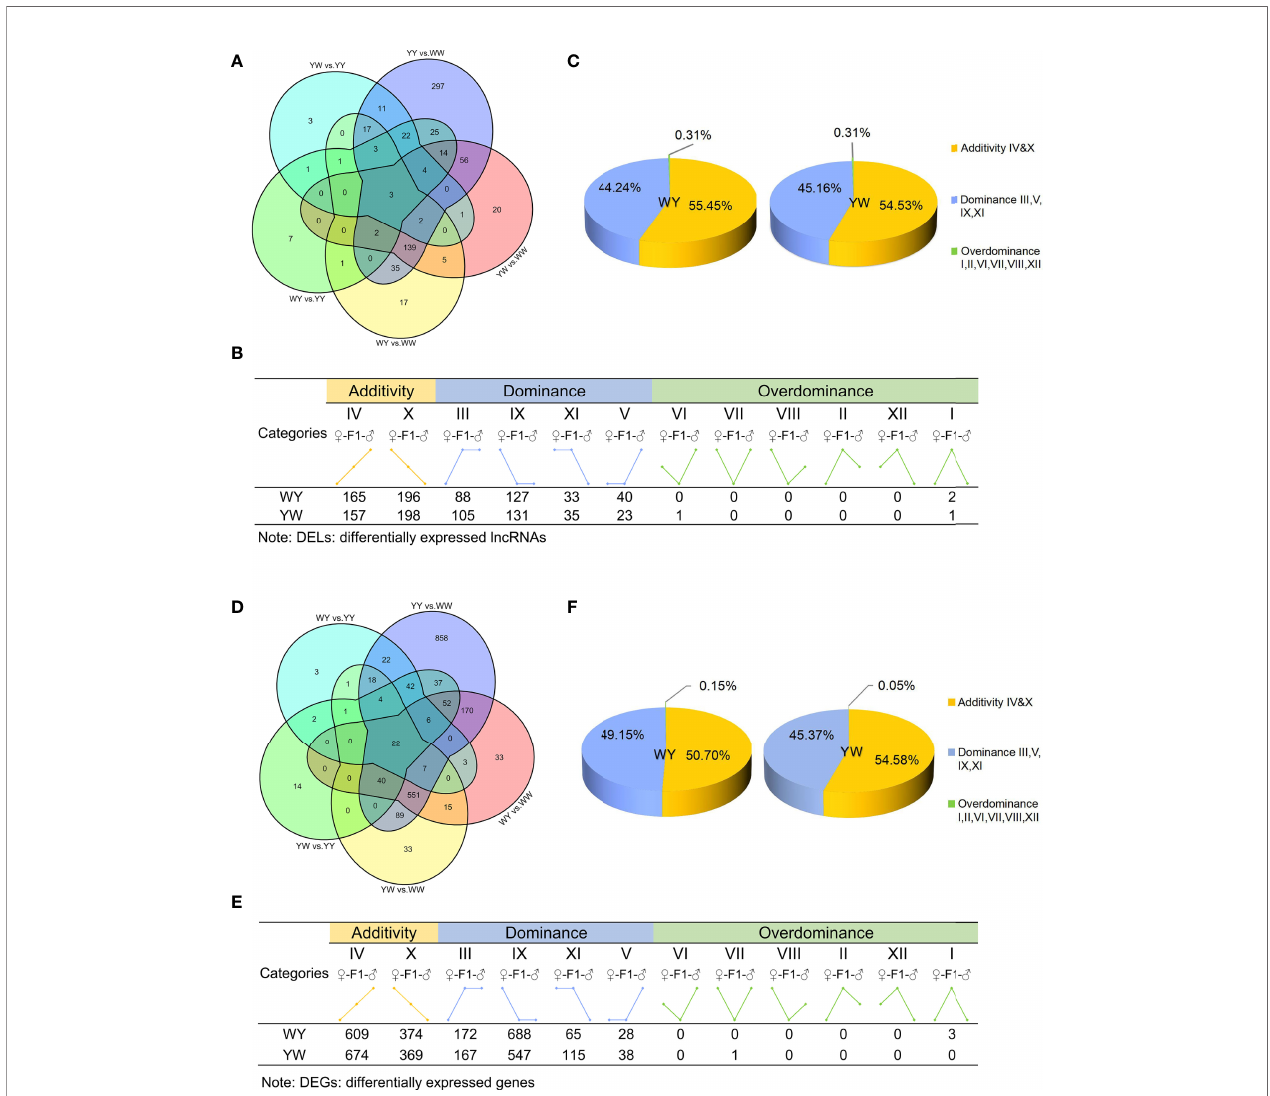
FIGURE 3 | Analysis of lncRNAs and genes inheritance patterns. (A) The number of differentially expressed LncRNAs (DELs) among purebreds and crossbreeds. (B) Inheritance patterns of DELs between crossbreeds. DELs were divided into 12 types, e.g., class I, II, III, IV, V, VI, VII, VIII, IX, X, XI, XII, and further classi fi ed into three inheritance patterns: additivity (class IV and X), dominance (class III, V, IX and XI) and overdominance (class I, II, VI, VII, VIII, XII), based on the level of gene expression exhibited by purebreds and crossbreeds. Additivity, dominance and overdominance are presented in orange, blue and green, respectively. (C) The proportion of DELs in additivity, dominance and overdominance pattern. (D) The number of DEGs among purebreds and crossbreeds. (E) Inheritance patterns of DEGs of crossbreeds. DEGs were divided into 12 types, e.g,. class I, II, III, IV, V, VI, VII, VIII, IX, X, XI, XII, and further classi fi ed into three inheritance patterns: additivity (class IV and X), dominance (class III, V, IX and XI) and overdominance (class I, II, VI, VII, VIII, XII), based on the level of gene expression exhibited by crossbreeds and purebreds. Additivity, dominance and overdominance are presented in orange, blue and green, respectively. (F) The proportion of DEGs in additivity, dominance and overdominance